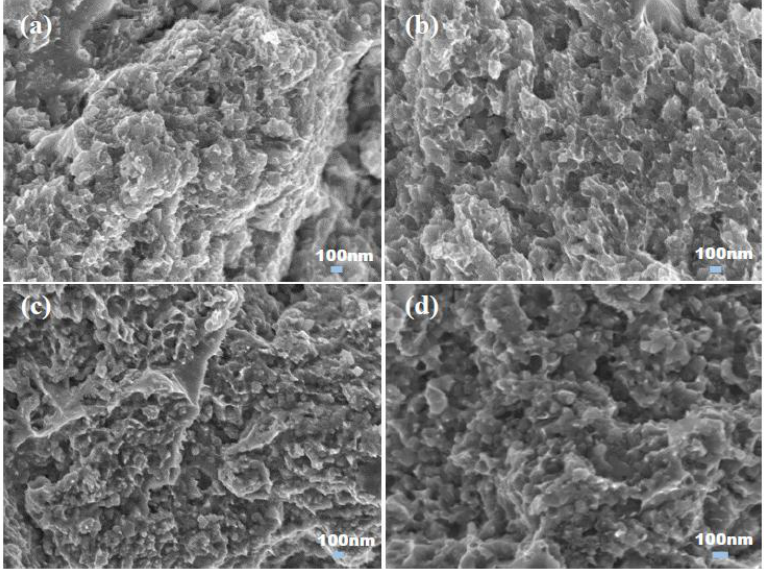
Figure 5. Fracture surfaces of the TiC–Cu nanocomposites spark plasma sintered at 900 °C: ( a ) 20 vol % TiC, nanocomposite A; ( b ) 20 vol % TiC, nanocomposite B; ( c ) 30 vol % TiC, nanocomposite A; and ( d ) 30 vol % TiC, nanocomposite B.